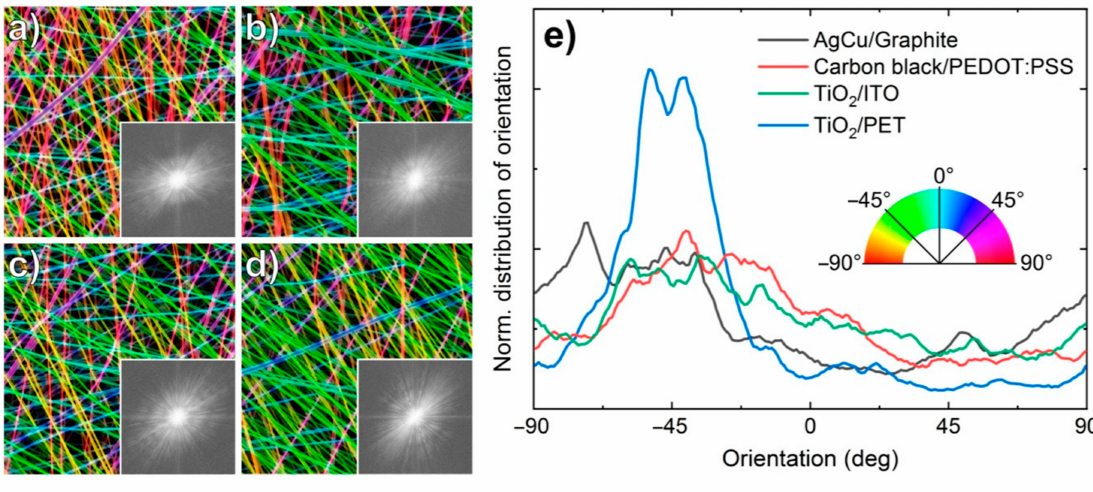
Figure 5. HIM images of the nanofibers color-coded according to their orientations on ( a ) Ag–Cu flakes/graphite, ( b ) carbon black/PEDOT:PSS, ( c ) TiO 2 /ITO and ( d ) TiO 2 /PET. Insets show FFT spectra of the respective HIM images; ( e ) angular distributions of the fibers calculated by